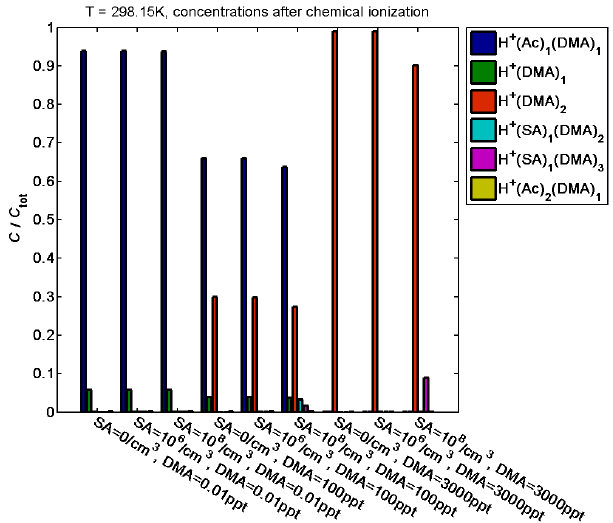
Figure 3. Relative concentrations of charged clusters after ioniza- tion grouped by cluster